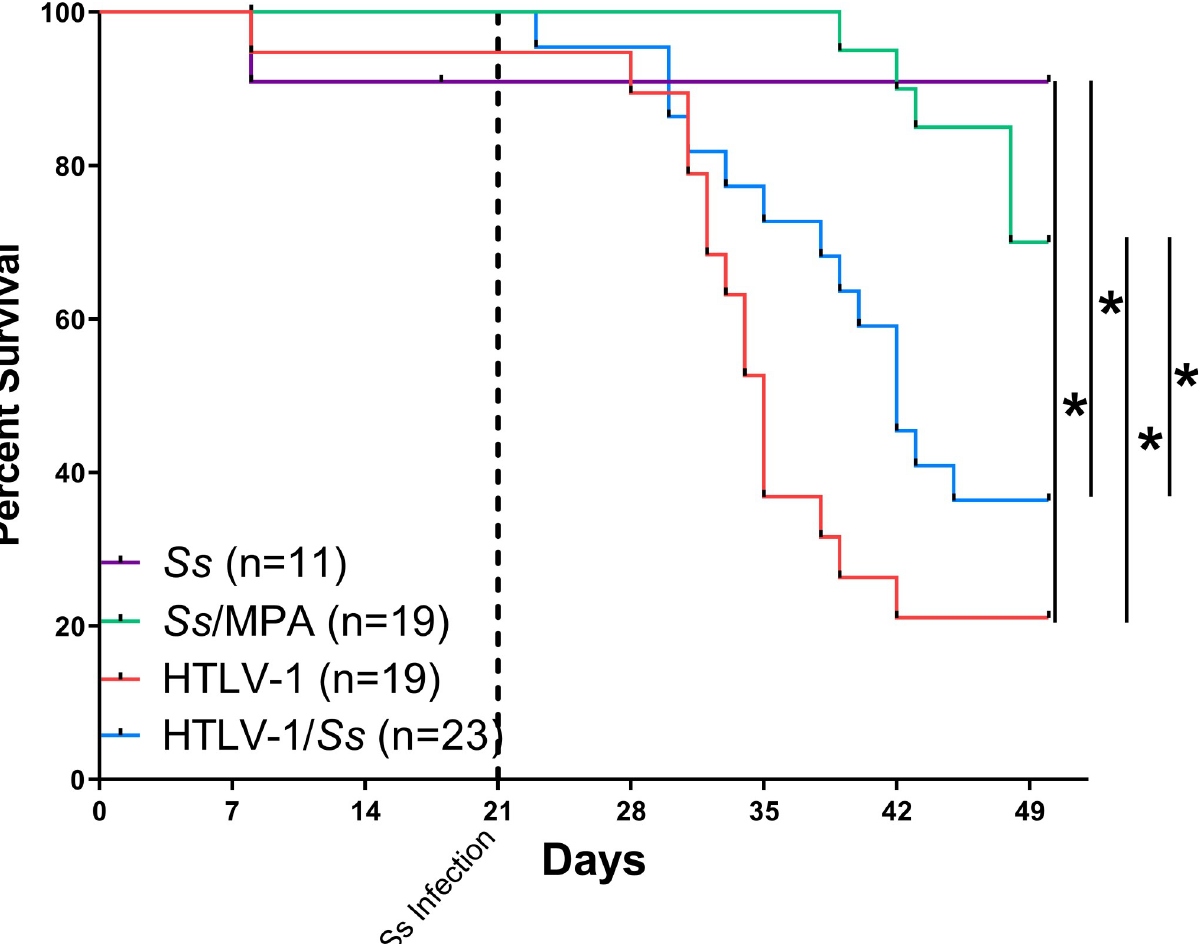
Fig 3. Mortality rates of humanized NSG mice during infection with HTLV-1 and Strongyloides stercoralis (Ss) . Mice were infected with either 5,000 S . stercoralis infective third-stage larvae, HTLV-1 or a combination of the two pathogens. As a positive control group, mice infected with S . stercoralis were treated with the steroid methylprednisolone acetate (MPA). Mortality rates were tracked throughout the 7-week course of the infection. The dotted vertical line indicates the date the mice were infected with S . stercoralis , 21 days post infection with HTLV-1. Mortality rates are a combination of three independent replicates and the total n value for each experimental group is included in the figure. Asterisk represents p < 0.05.